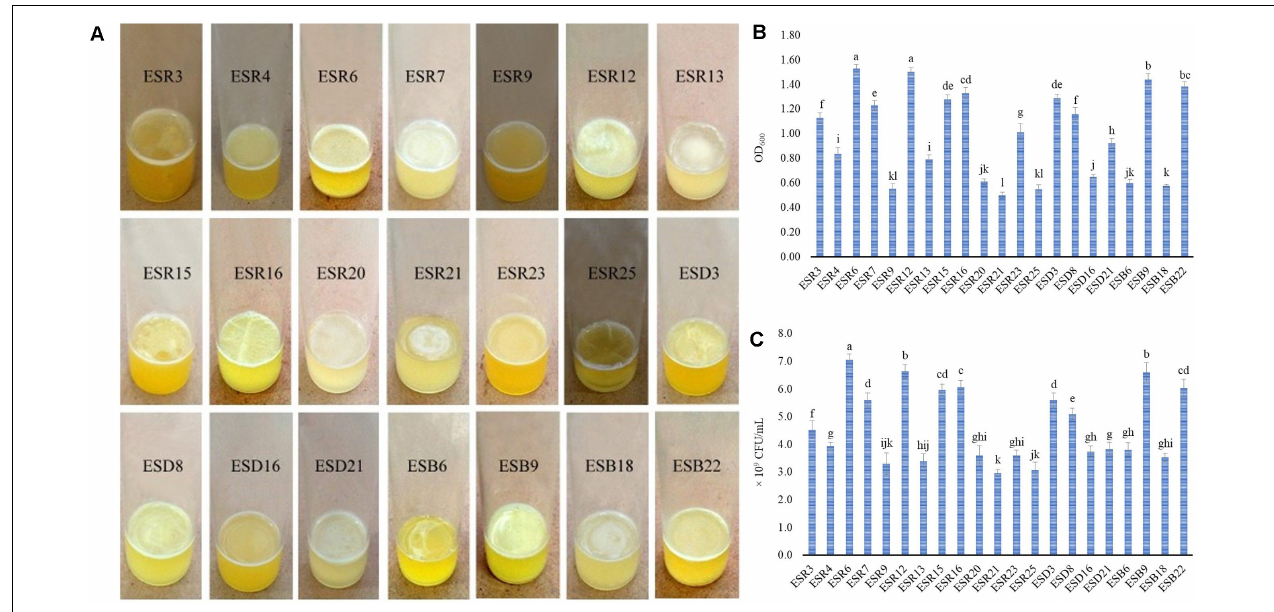
FIGURE 1 | Production of AL biofilms by different rhizobacterial strains after a 72-hour incubation at 28 ◦ C in stationary conditions (A) . Biomass of AL biofilms determined at 600 nm (B) . Number of bacteria-coupled with AL biofilms (C) . The values are mean, and error bars indicate standard deviation ( ± ) of the three independent experiments. Values having different letters are significantly different from each other according to Fisher’s least significant difference (LSD) test ( P ≤ 0.001).